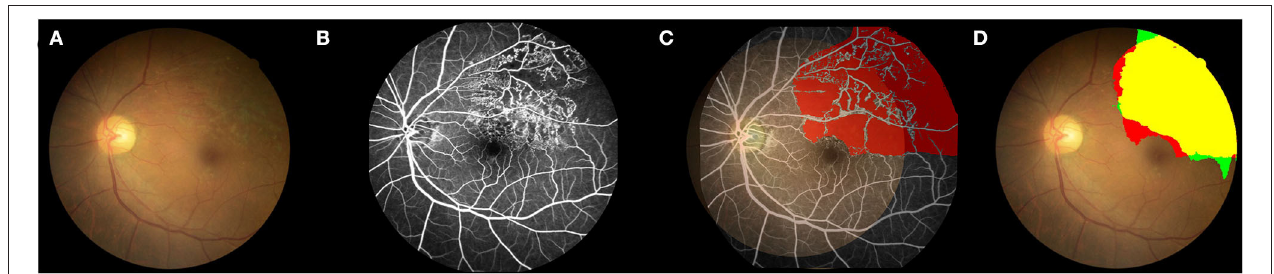
FIGURE 2 | Example of the comparison between the second DL model and FFA in detecting the non-perfusion area. (A) Color fundus photograph (CFP). (B) FFA image shows the superior-temporal non-perfusion area. (C) Labeling the NPA in the CFP according to the FFA images. The CFP image was registered with the corresponding FFA image through the superposition of the blood vessels. The NPA in the FFA image was then labeled in the CFP for the following DL training. (D) TP, True positive; yellow region; TN, true negative, colorless region; FP, false positive, green region; and FN, false negative, red region. Green plus yellow shows the NPA indicated by the DL model; red plus yellow shows the true NPA indicated by FFA. DL, deep learning; CFP, color fundus photograph; FFA, fundus fluorescein angiography; NPA, non-perfusion